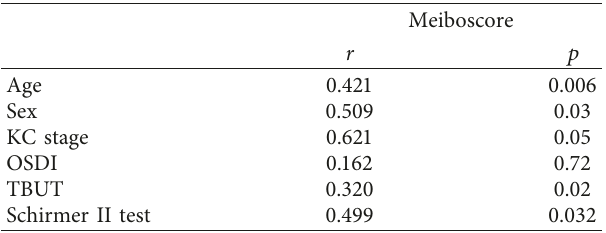
Table 4: Correlation between the meiboscore and other factors in KC patients.